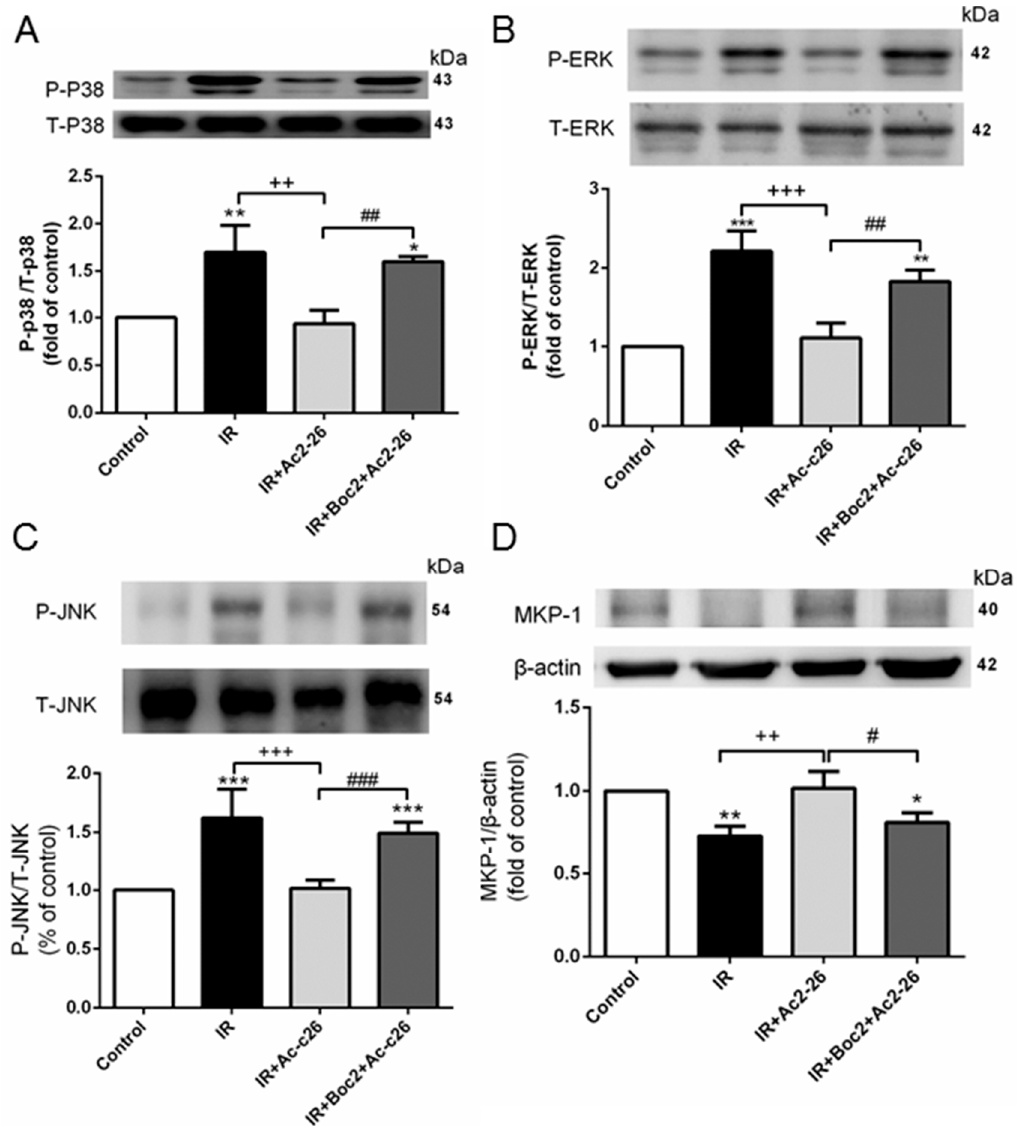
Figure 8. Effect of Ac2-26 and Boc2 on mitogen-activated protein kinase (MAPK) and mitogen-activated protein kinase phoshphotases-1 (MKP-1) expressions in lung tissue. The phosphorylation of p38 protein kinase (p38) ( A ); extracellular signal-related protein kinase 1/2 (ERK) ( B ); and c-Jun N-terminal kinase (JNK) ( C ) was enhanced in the IR group. The effect was attenuated by Ac2-26 treatment. In contrast, the expression of MKP-1 protein ( D ) was decreased in the IR group, but reversed by Ac2-26 treatment. When Boc2 was added, the protective effect of Ac2-26 was blocked. β -actin served as loading controls. An example of a blot is shown. All data are shown as means ± SD ( n = 6 per group). * p < 0.05, ** p < 0.01, *** p < 0.001, compared with the control group; ++ p < 0.01, +++ p < 0.001, compared with the IR group; and # p < 0.05, ## p < 0.01, ### p < 0.001, compared with the IR + Ac2-26 group.